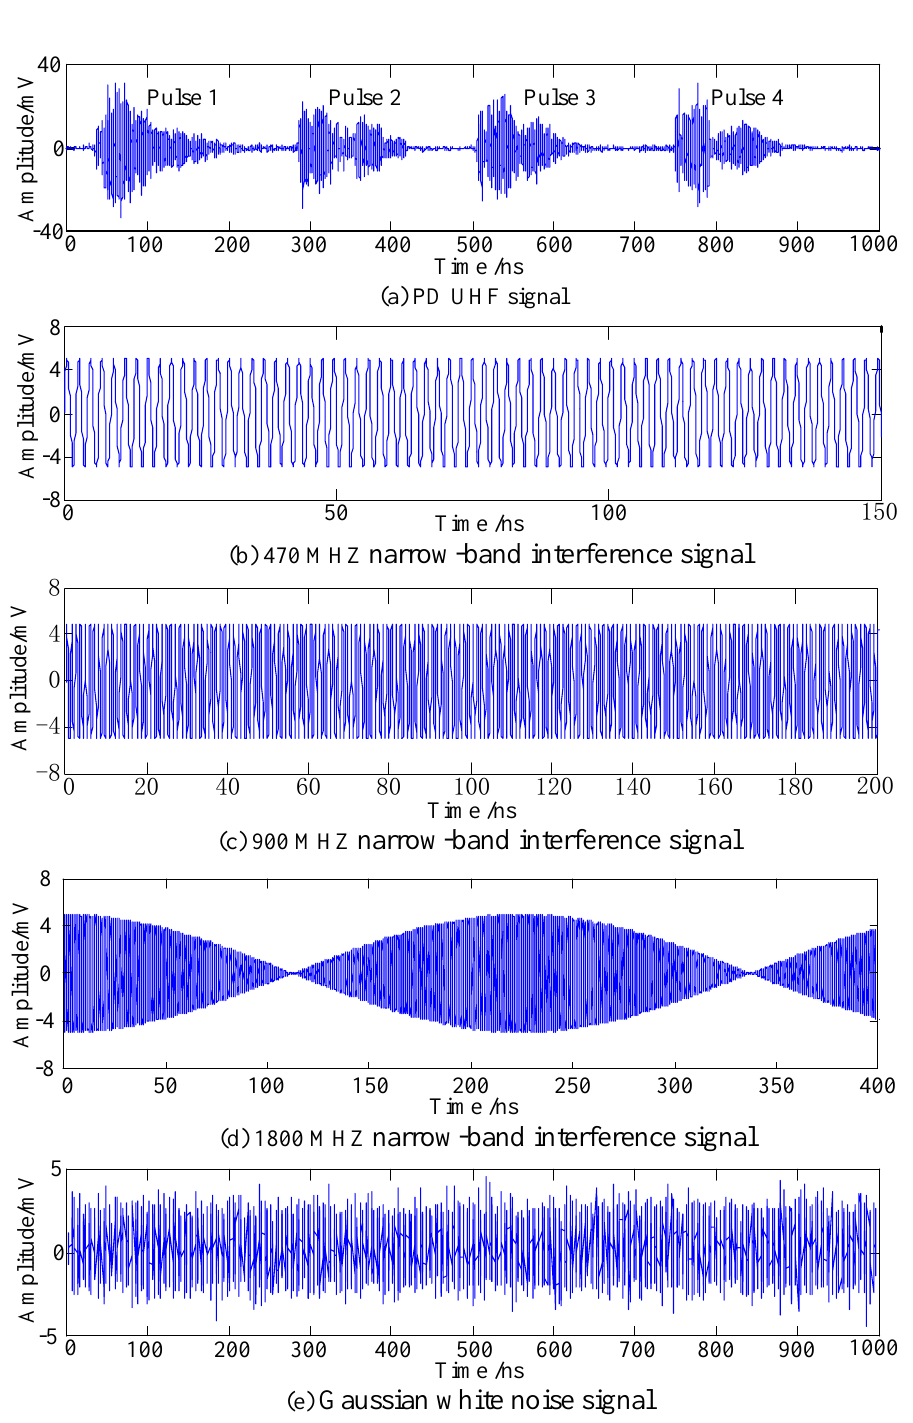
Figure 9. De-noised results using the blind source separation method.